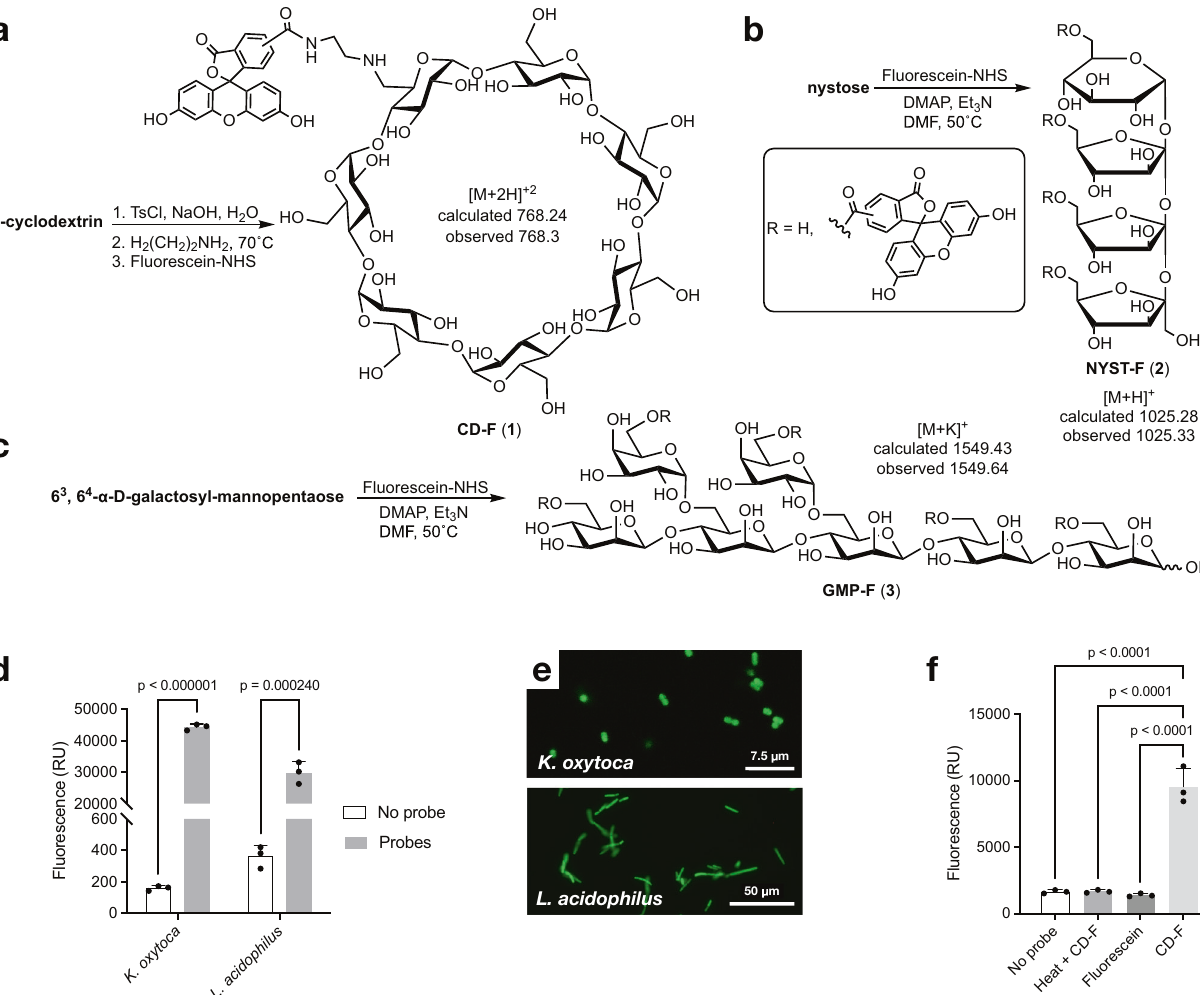
comparison test. e Confocal microscopy image of fl uorescently labeled K. oxytoca and 2-photon microscopy image of L. acidophilus after incubation with CD-F and NYST-F. Bacteria in the exponential phase were washed and incubated for 1h with the probes (500nM) and then fi xed with 4% paraformaldehyde. f Fluorescence quanti fi cation of bacteria isolated from stool samples after incubation with free fl uorescein (4.4 μ M) or CD-F (4.4 μ M) for 1h with or without heat shock pretreat- ment of the gut microbiota for 10min at 65°C. Data are the mean±SD ( n =3). Statistical signi fi cance compared to the labeled condition by one-way ANOVAwith Bonferroni ’ s multiple comparison test. Source data and statistical details are pro- vided as a Source data fi